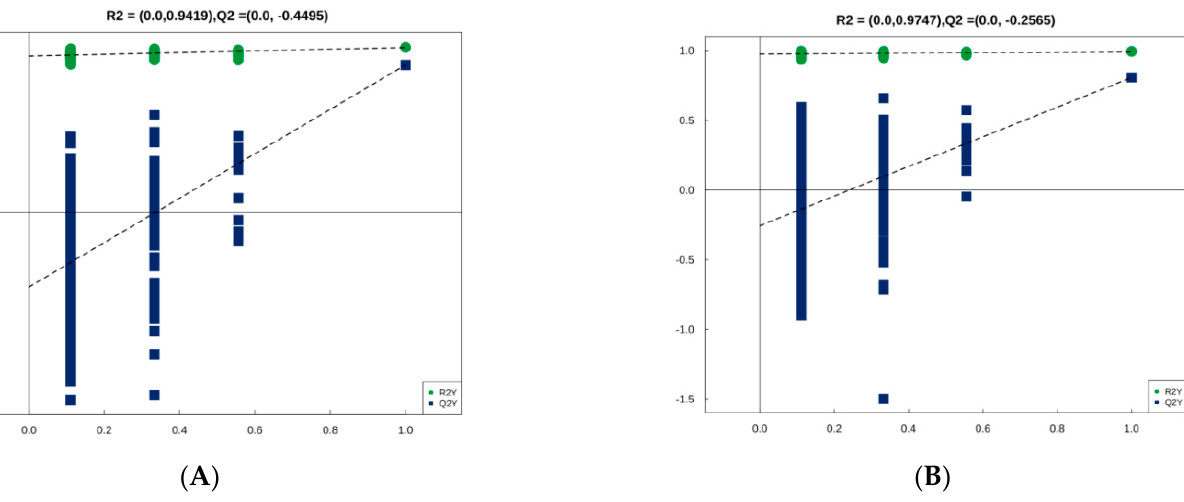
Figure 1. PCA analysis of beef LL muscle during postmortem aging at 4 °C (days 0, 0.5, 1, and 2). PCA is made by all the peak ions. The clustering degree of QC samples reflects the repeatability of the experiment. In the score plot, the green, dark blue, purple, and orange dots represent the sample group at days 0, 0.5, 1, and 2 during postmortem aging, respectively. The blue dots represent the QC samples.